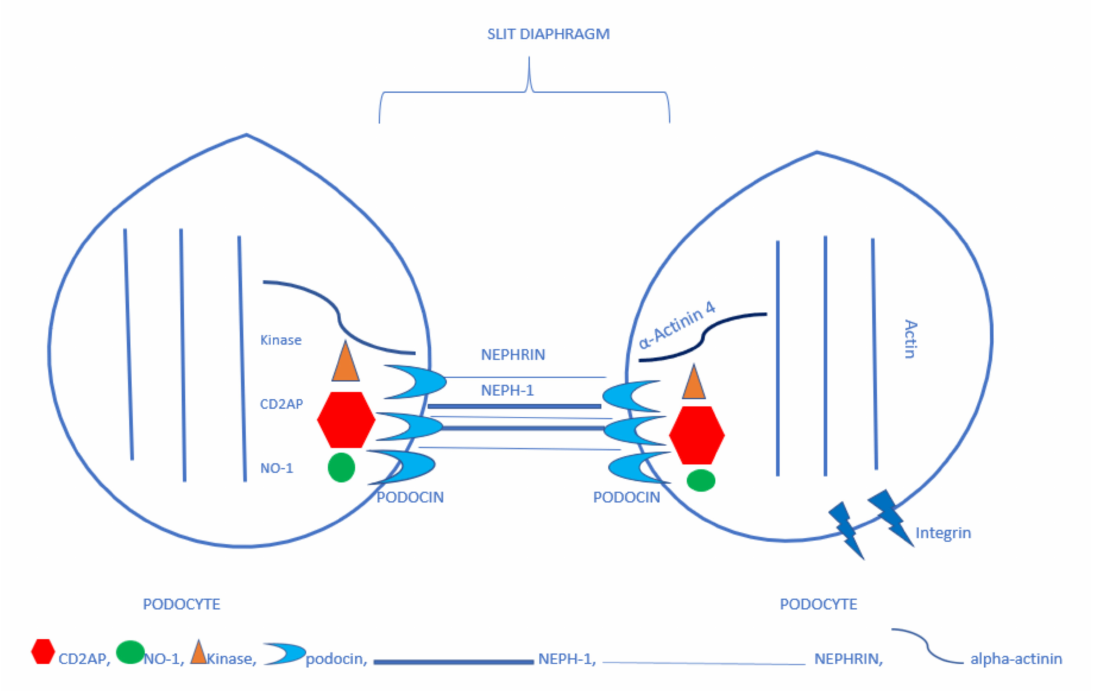
Figure 1. The simplified picture of the construction of a slit